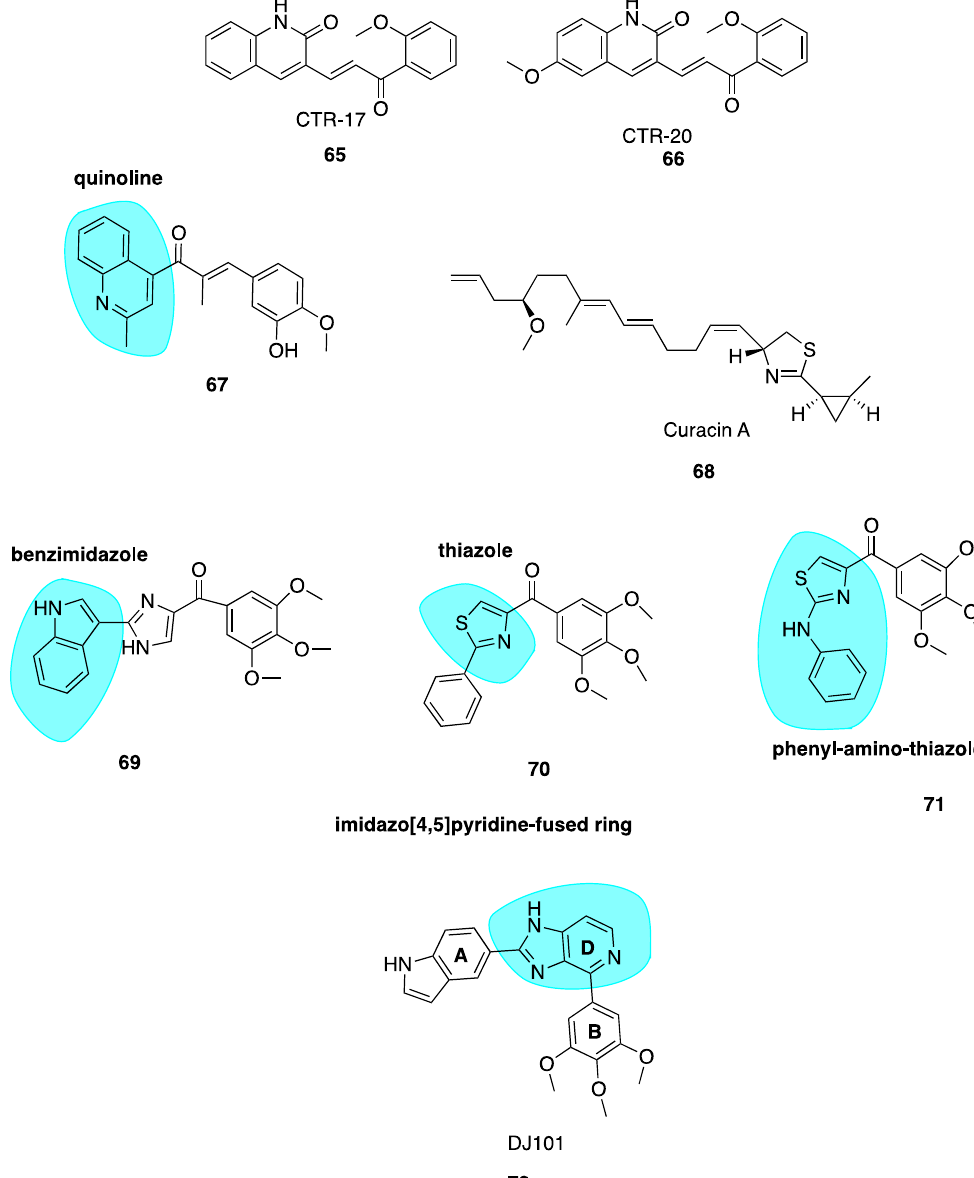
Figure 10. Structures of colchicine-binding site inhibitors 65 – 72 .